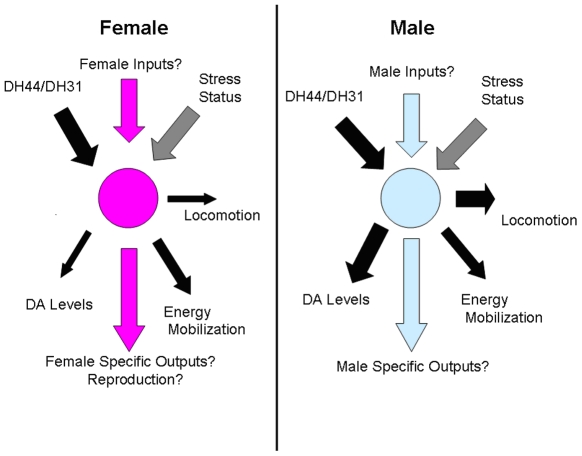
Model of corazonin neuronal function in Drosophila.Corazonin neurons in both males and females express the receptors for DH44 and DH31 (Johnson et al., 2005) but may also have sex-specific inputs that are currently unknown. It may be that stress status is related either through these inputs or yet unidentified inputs. Corazonin neurons participate either directly or indirectly to regulate locomotor activity, dopamine levels, and triglycerides but exhibit sex-specific differences in the extent and nature of these phenotypes. Arrow size reflects the magnitude of interactions. Additionally, it may be that there are sex-specific targets of corazonin neurons.